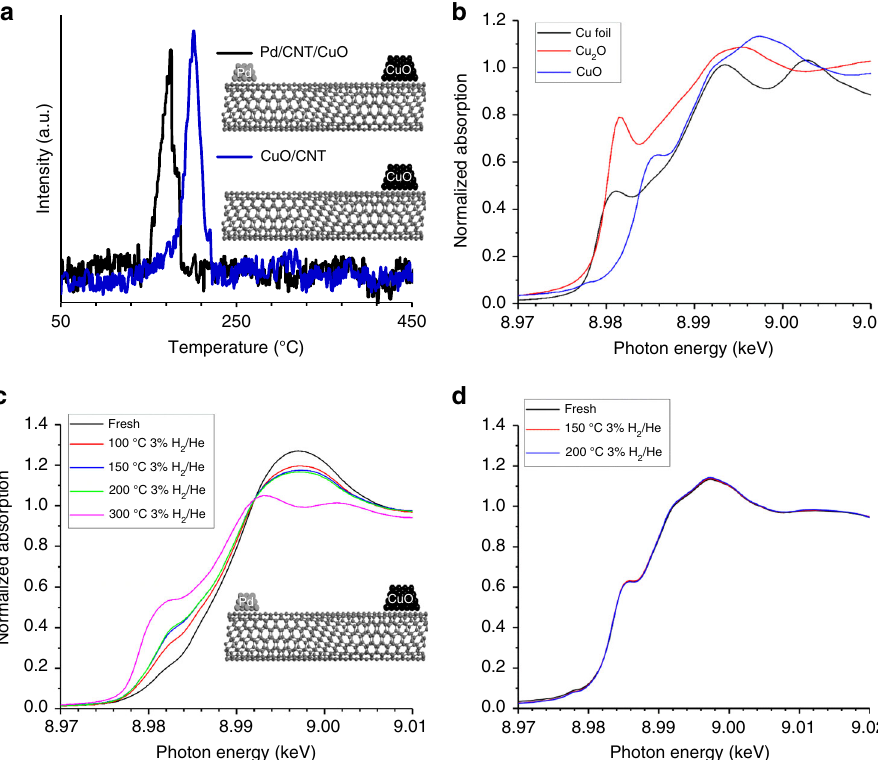
Fig. 2 Facilitated reduction of Cu by Pd on the opposing end of a carbon nanotube. a TPR pro fi les of CuO/CNT and Pd/CNT/CuO catalysts performed with a fl owing 5% H 2 /Ar stream at a ramp rate of 5 °C/min. b Cu K edge XANES of Cu foil (black), Cu 2 O (red), and CuO. (blue). c XANES of fresh Pd/CNT/ CuO (black) and after reduction in 3% H 2 in He at 100 (red), 150 (blue), 200 (green), and 300 o C (pink). d XANES of fresh CuO physically mixed with CNTs (black) and after reduction in 3% H 2 in He at 150 (red) and 200 o C